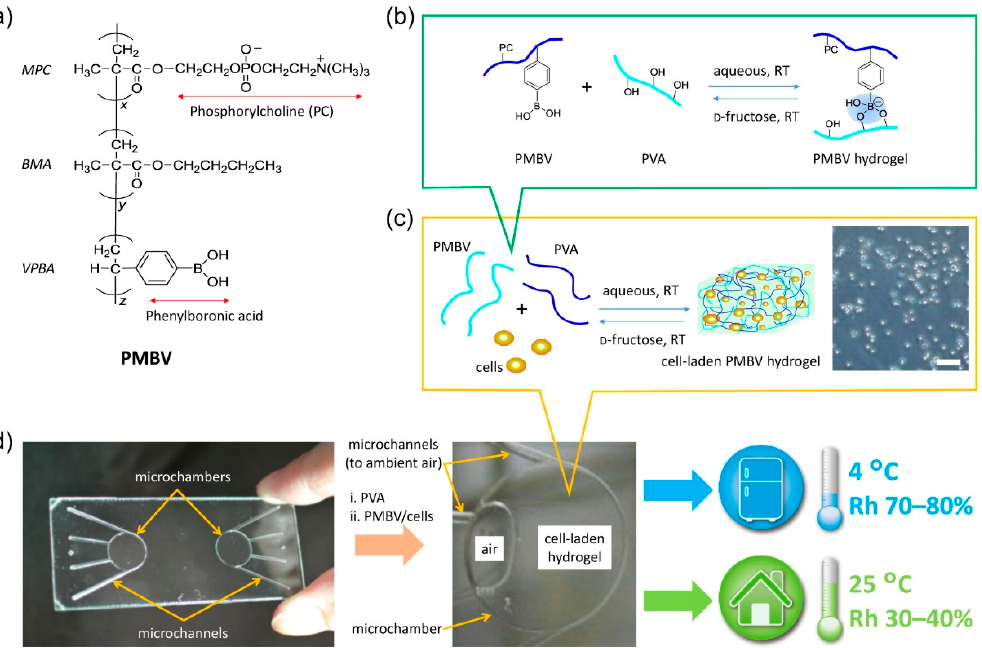
Figure 5. Spontaneous packaging and hypothermic storage of cells in stoichiometric conditions [56]. ( a ) PMBV hydrogel; ( b , c ) cross-linking reaction between PMBV and PVA; ( d ) microchanels in a glass microchip. Scale bar is 100 µm ( c ). PMBV: poly (2-methacryloyloxyethyl phosphorylcholine- co - n -butyl methacrylate- co - p -vinylphenylboronic acid); MPC: methacryloyloxyethyl phosphorylcholine; BMA: n -butyl methacrylate; VPBA: p -vinylphenylboronic acid; PVA: poly (vinyl alcohol).